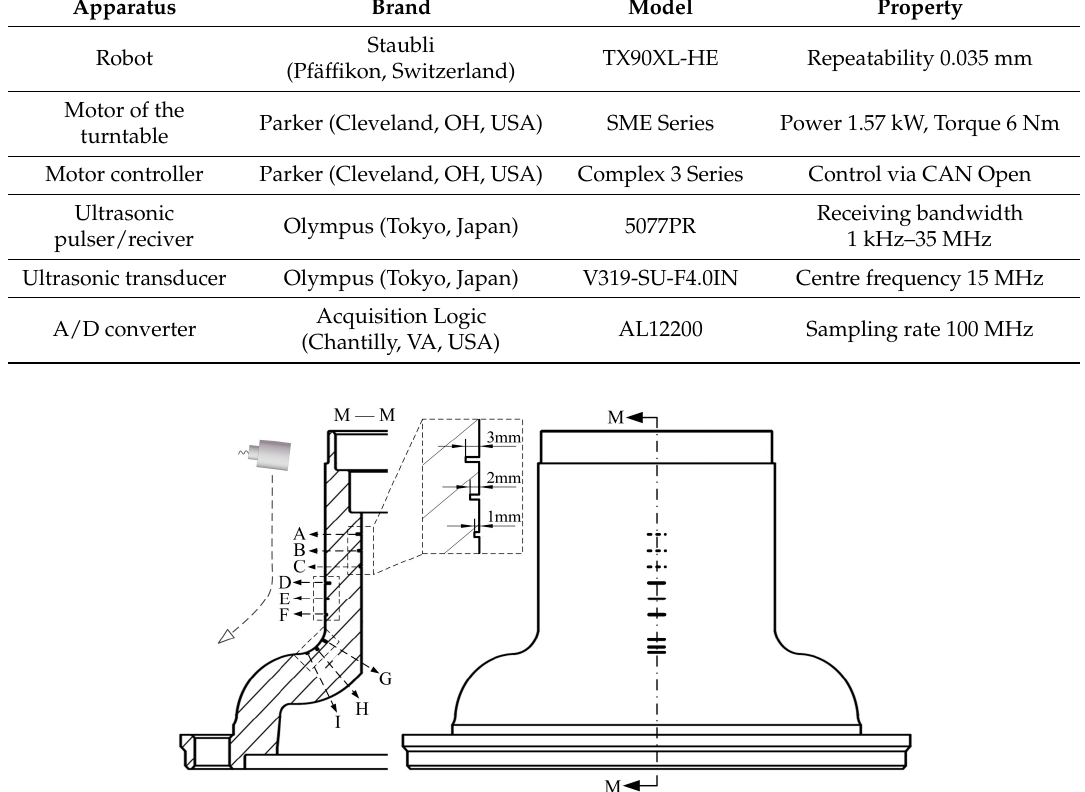
Table 1. Main components of the robot-assisted UT system.